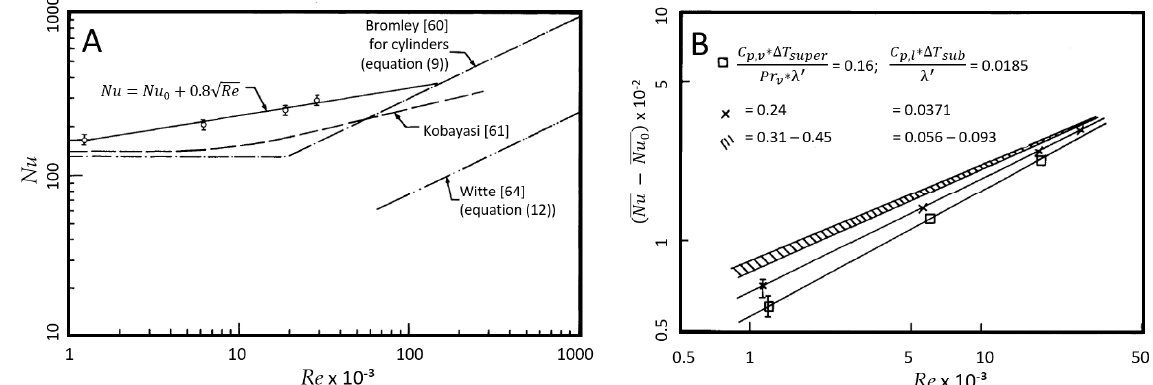
Figure 17. Heat transfer coefficient (represented by Nusselt number (Y-axis)) during forced convection around a 19-mm stainless steel sphere as a function of relative velocity (represented by Reynold number (X-axis)) for different sphere and coolant temperatures (adapted from Reference [83]): ( A ) Saturated water; ( B ) subcooled water.